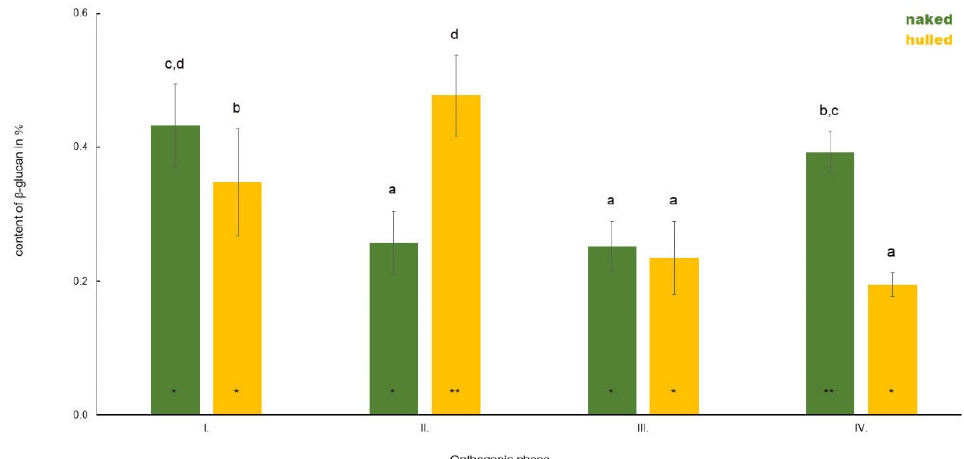
Figure 6. Comparison of the content of β -D-glucan in the stem of hulled and naked oat samples during plant ontogenesis. Different letters indicate a statistically significant difference between individual seed types (naked and hull) in specific ontogenetic phase evaluated by ANOVA (LSD, p ≤ 0.05). Star symbols (* and **) represent statistically significant difference between naked and hulled samples evaluated for each ontogenetic phase individually by ANOVA (LSD, p ≤ 0.05).